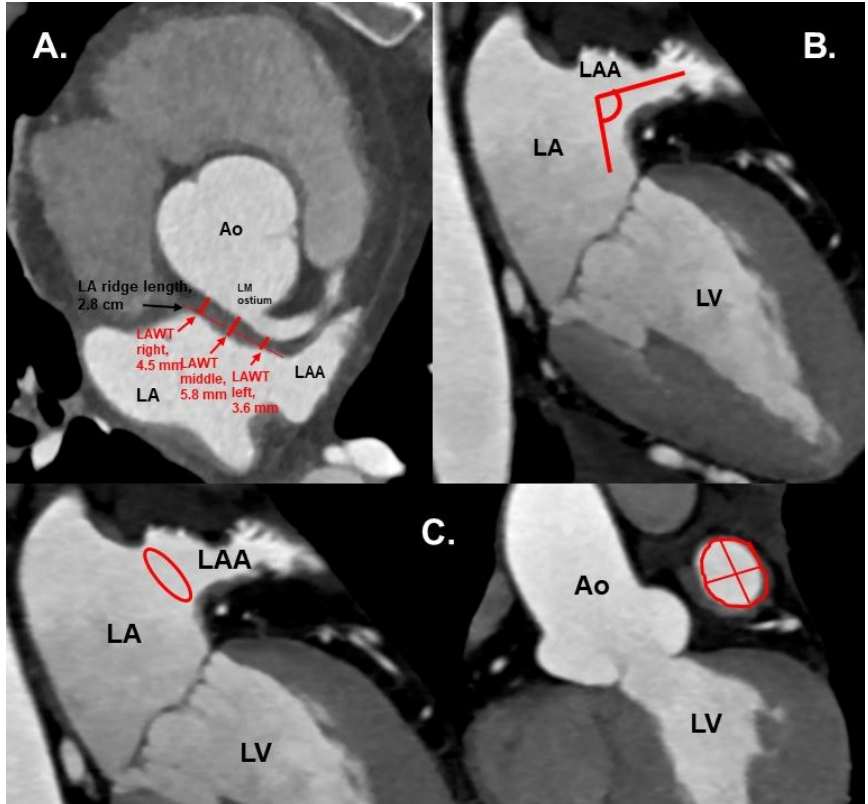
Figure 3. ( A ) Cardiac CTA: axial plane. Red arrows show the LAWT measurements at the left, middle and right points, and the LA ridge length. Measurements were taken at the plane of left main coronary ostium. ( B ) CTA: axial oblique plane, showing LAA ostium angulation (red lines) to orthogonal plane. ( C ) CTA with axial oblique planes of the heart. Left: LAA ostium area shown in red circle. Right: LAA ostium area (red circle), length and width (red lines). Ao—aorta, LA—left atrium, LAA—left atrial appendage, LAWT—left atrial wall thickness, LM—left main coronary artery, LV—left ventricle.